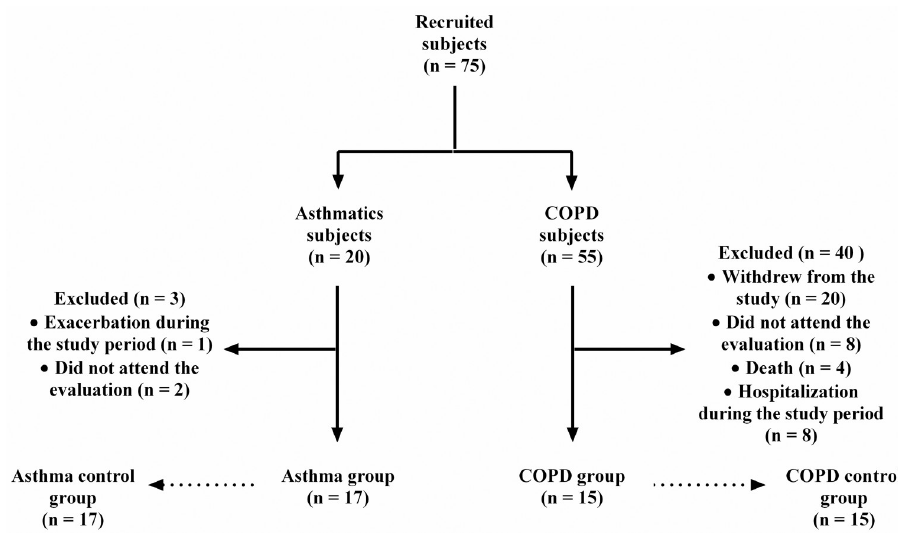
Fig 1. Flowchart selection of